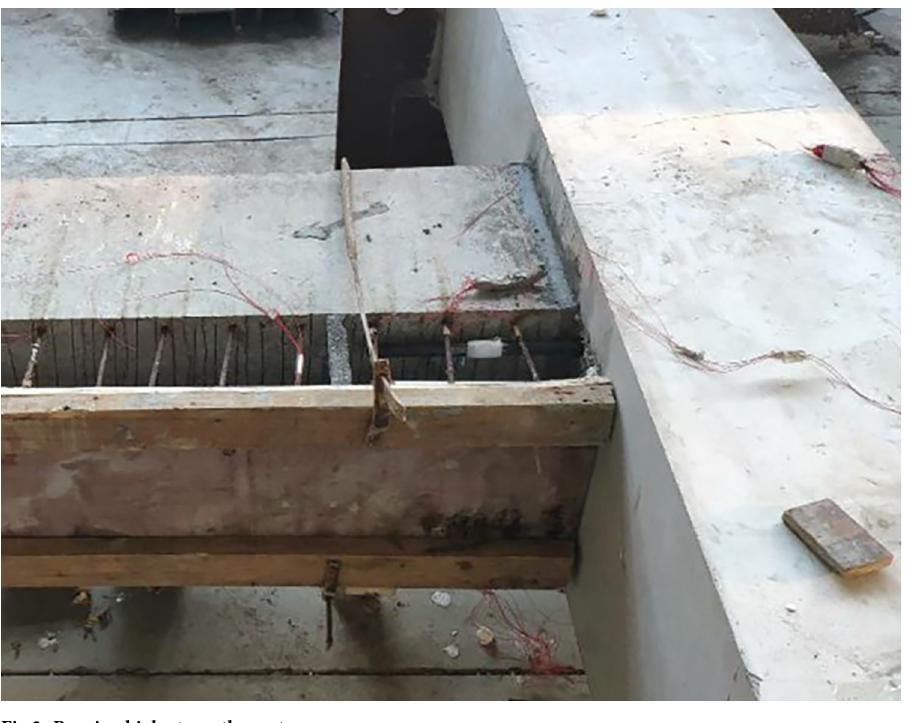
Fig 3. Pouring high-strength